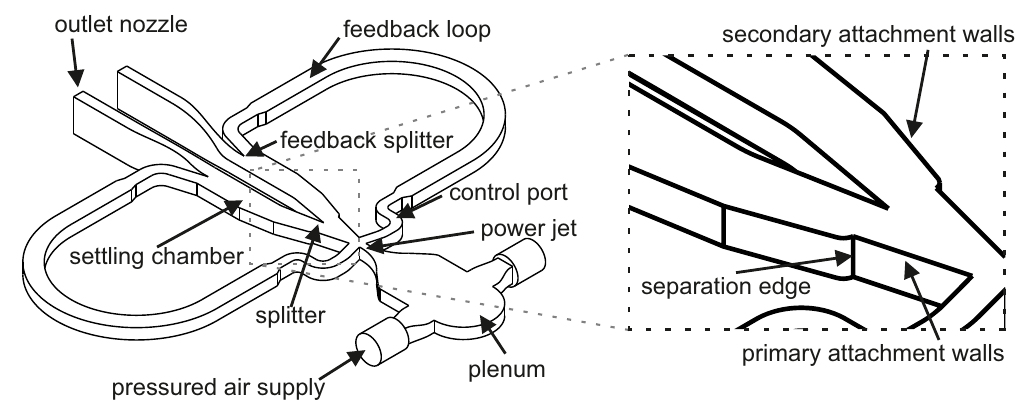
Figure 3. Definitions used for parts of an FO-PJA geometry.